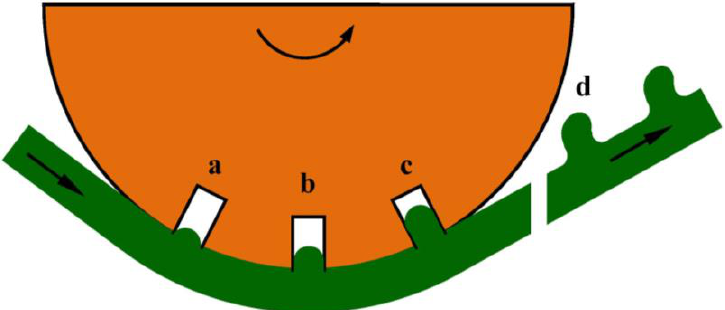
Figure 1. Formation of replication defects during thermal roller imprinting: ( a ) engaging; ( b ) imprinting; ( c ) incompletely filled cavity; ( d ) distorted